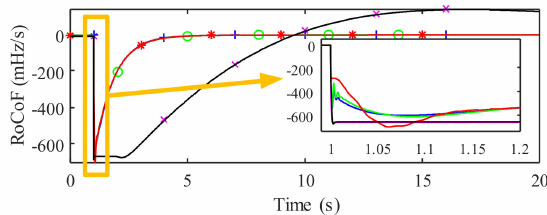
Figure 13. Rate of change of frequency ( RoCoF ∆ t ) variation on load change for VOC (black, solid line), VSM (red, * marked), VI (green, circle marked), and droop (blue, + marked) control systems, as well as no VSC connection (magenta, × marked).